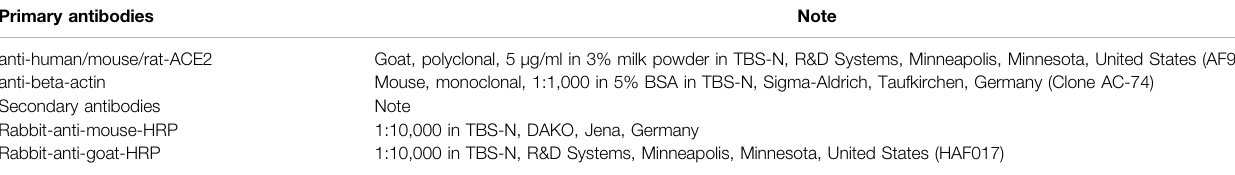
TABLE 3 | Primary and secondary antibodies used for western blot detection. Primary antibodies Note